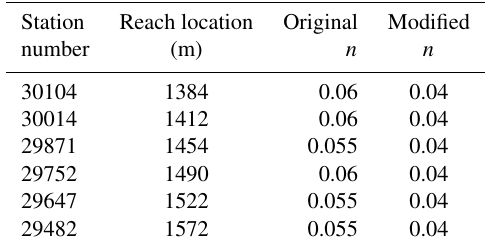
Table A1. Modified Manning’s n for cross-section stations in Waller Creek data set to provide numerical stability of unsteady